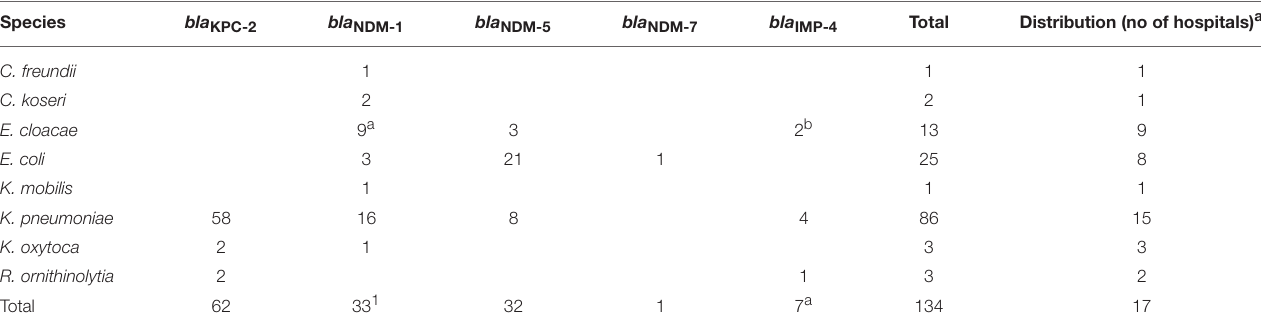
TABLE 1 | CRE strains and carbapenemase genes in the present study.